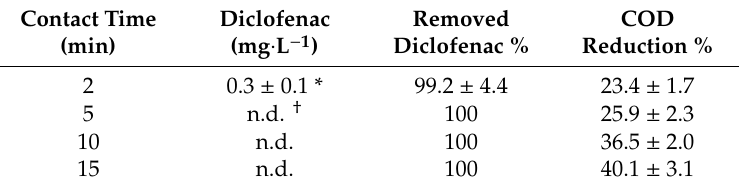
Table 6. UV radiation treatment combined with H 2 O 2 (5 mg · L − 1